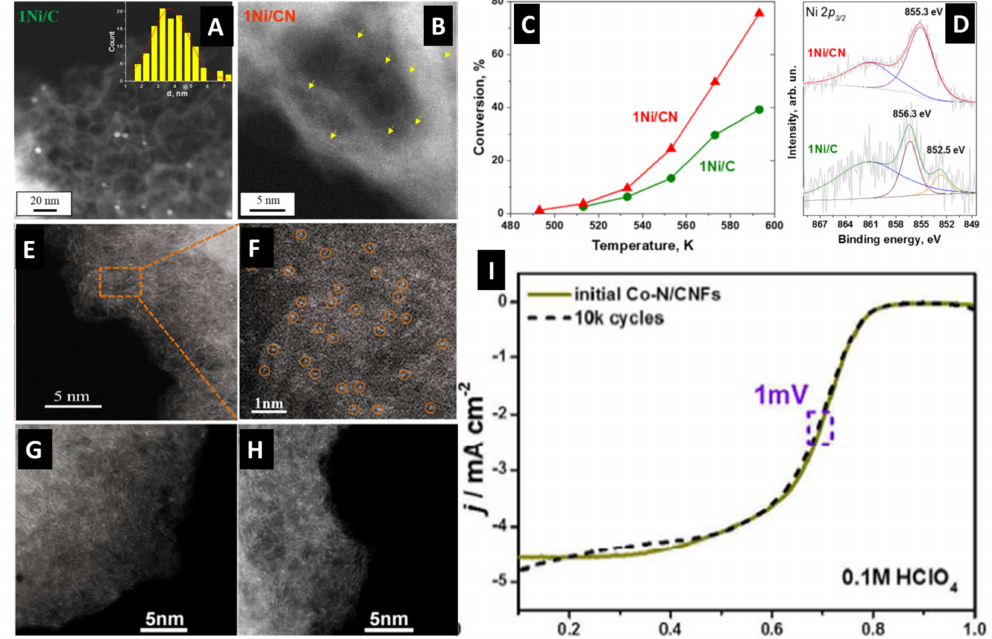
Figure 4. ( A , B ) HAADF-STEM images for 1Ni/C and 1Ni/CN (yellow arrow shows isolated single-atom Ni), ( C ) formic acid conversion into hydrogen, and ( D ) Ni 2p 3/2 XPS deconvolution peaks for 1Ni/C and 1Ni/CN. Adapted with permission from [62], ( E ) aberration-corrected STEM image, ( F ) enlarged images of Co-N/CNFs (orange circle: single-atom Co), ( G , H ) HAADF-STEM images of Co single atoms in different regions for Co-N/CNFs catalyst, and ( I ) stability test of Co-N/CNFs within 10,000 cycles in O 2 -saturated 0.1 M HClO 4 . Adapted with permission from